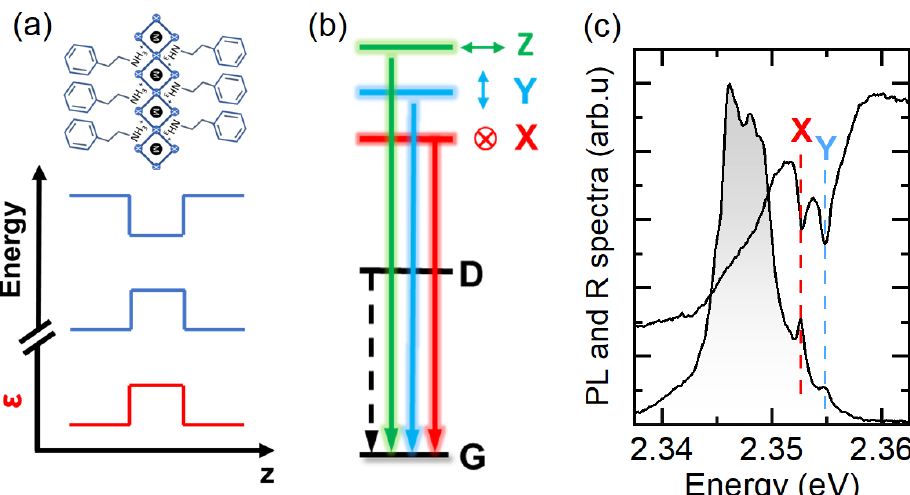
Figure 1. ( a ) Schematic view of a 2D perovskite of thickness n = 1 together with the conduction and valance band alignment and spatial dependence of dielectric screening. ( b ) Schematic of the band edge exciton fine structure of (PEA) 2 PbI 4 (PEA—phenylethylammonium). G is the ground state of the system (no excitons), D is the dark state, and X, Y, and Z are the three bright states with orthogonally oriented dipole moments. ( c ) Photoluminescence (grey shading) and reflectance (black line) spectra of (PEA) 2 PbI 4 single crystal. The two in-plane bright exciton states are indicated by X and